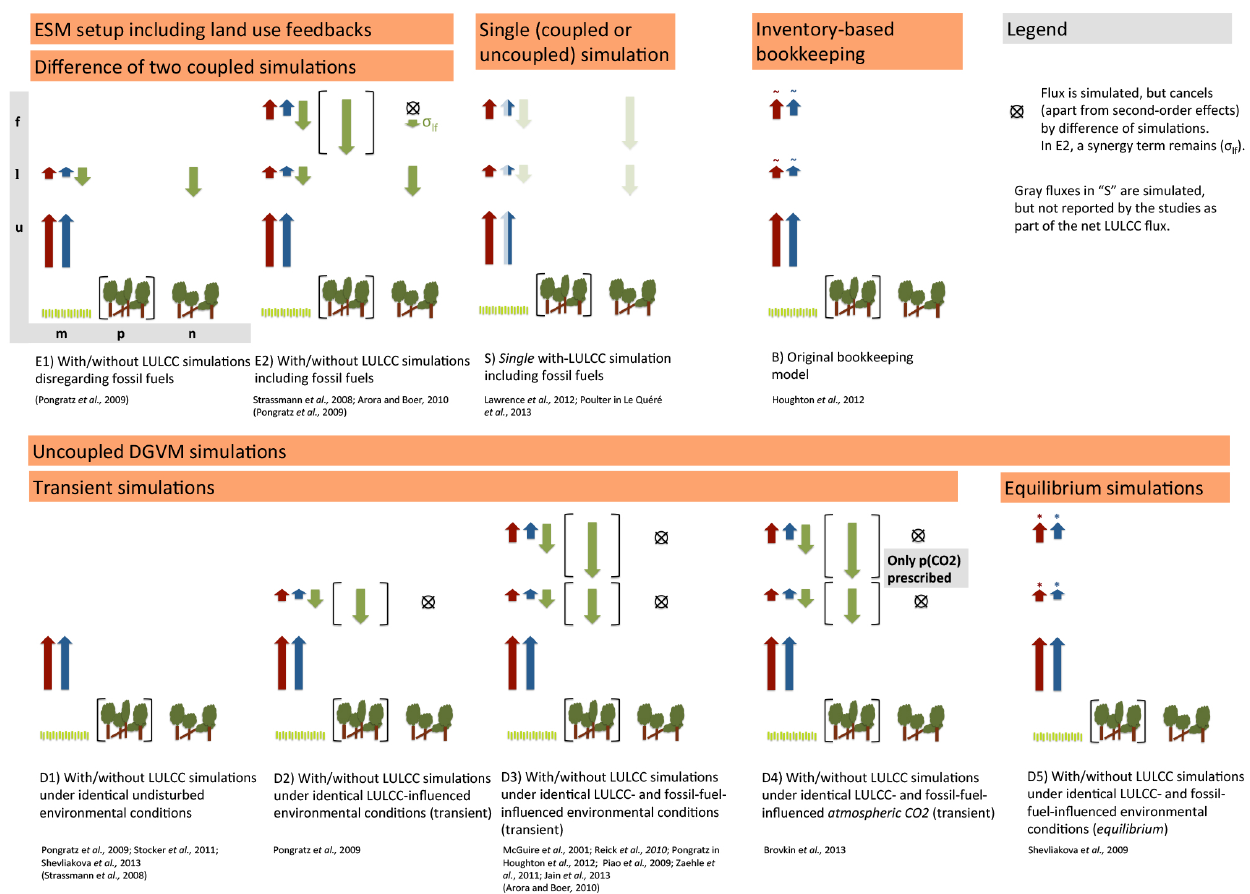
Fig. 2. Comparison of published methods to estimate the net LULCC flux with respect to flux components that are included or excluded. The complete set of flux components has been shown in Fig. 1b. Note that all simulations that account for the combined effects of LULCC- induced and other environmental changes ( l and f ) include synergy effects ( δ lf = δ l + δ f + σ lf ; see Sect. 2.6); the f arrows are implicitly meant to include these synergies. Tilde and asterisk indicate that fluxes account for environmental changes, but not in a transient way: method B prescribes inventory-based carbon stocks as constant throughout the historical simulation; method D5 assumes the biosphere to be in equilibrium with present-day environmental changes throughout the historical simulation. References in parentheses indicate fluxes that were studied by the authors but not intended to represent their interpretation of the “net LULCC flux”; instead they were used to diagnose the influence of different approaches or flux terms, or to compare with other published